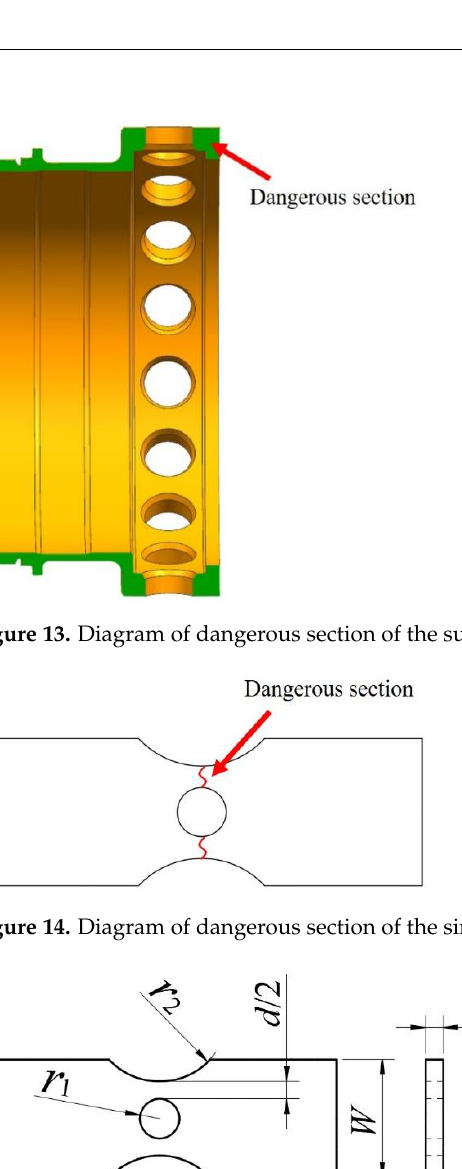
Figure 15. Diagram of the simulative specimen.